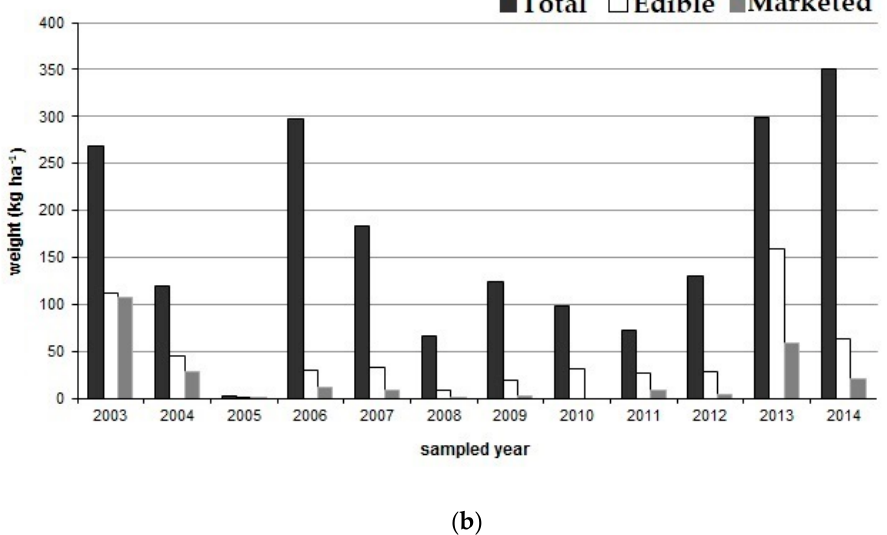
Figure 1. ( a ) Average total and mycorrhizal fresh weight (kg ha − 1 ) production by sampled year. ( b ) Average total, edible and marketed fresh weight (kg ha − 1 ) production by sampled year. Table 2. Total fresh weight (fw kg ha − 1 ), dry weight (dw kg ha − 1 ) and number of sporocarps per hectare (ns ha − 1 ) by plot and sampled year. Plot